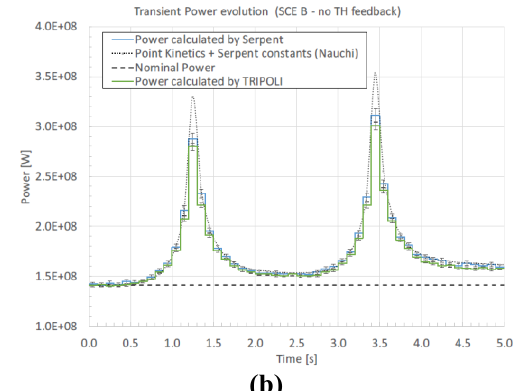
Figure 6: Cross section of a TMI-1 mini-core (a) and the power change for a control rod extraction of the central fuel assembly (b) predicted by SERPENT2 and TRIPOLI and compared to a point kinetics